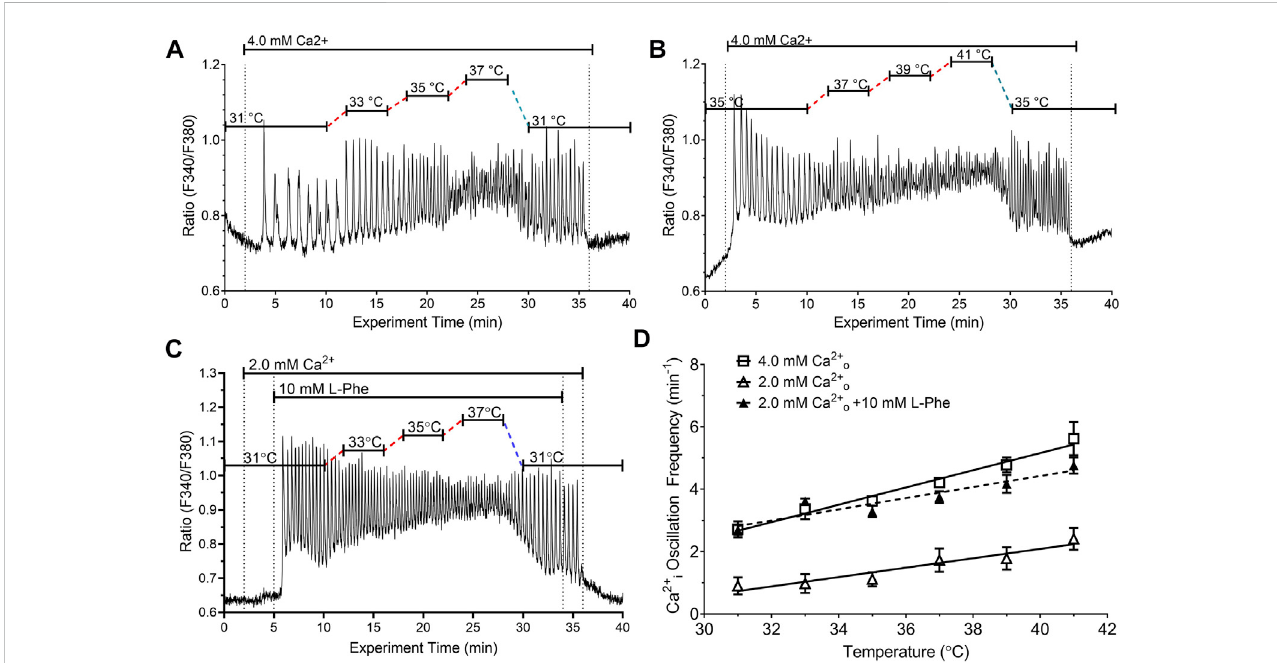
FIGURE 2 Impact of temperature on the frequency of Ca 2+ o -induced Ca 2+ i oscillations in the absence or presence of CaSR positive modulator L-Phe. HEK-CaSR cells were loaded with fura-2 AM then transferred to amicro fl uorescence apparatus and perifused with physiological saline solution (PSS). After a brief period of equilibration at control Ca 2+ o (0.5 mM), Ca 2+ o was increased acutely to either (i) 4.0 mM or (ii) 2.0 mM in the absence or presence of 10 mM L-Phe. The temperature was adjusted as required using a customised heating system (see Methods). In (A, B) , Ca 2+ o was increased acutely from 0.5 mM to 4.0 mM andthetemperaturewasadjustedintheranges31 ° C – 37 ° Cand35 ° C – 41 ° Crespectively. Thedottedlinesindicate2 minperiodsoftemperatureadjustment.In (C) , the cells were exposed initially to 31 ° C at control Ca 2+ o (0.5 mM) and the Ca 2+ o level was then increased to 2.0 mM followed by the addition of L-Phe (10 mM). Panel (D) presents the combined results of 3-4 experiments in each case. Temperature-dependent changes in Ca 2+ i frequency exhibited linear relationships for 4.0 mM Ca 2+ o (open squares) and 2.0 mM Ca 2+ o in the absence (open triangles) or presence ( fi lled triangles) of 10 mM L-Phe.